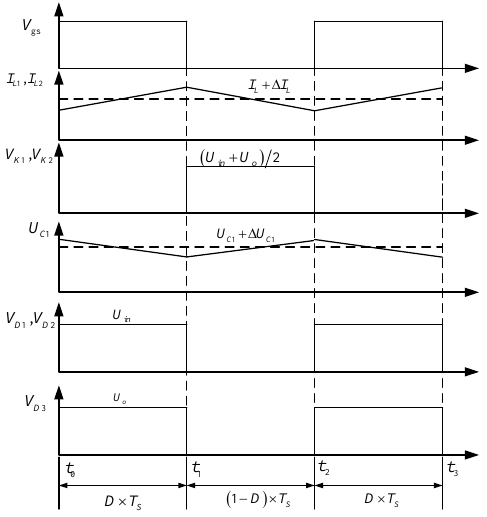
Figure 6. Double-boost converter working waveform.